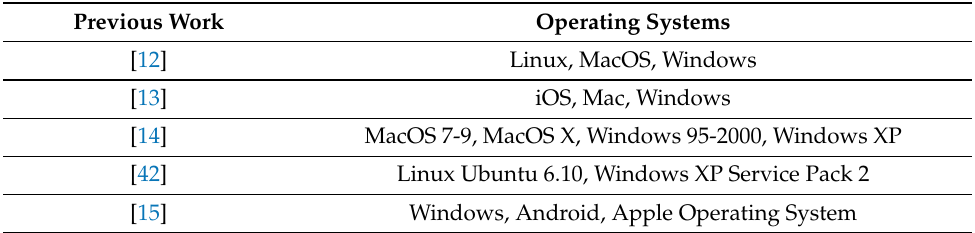
Table 11. List of operating systems analyzed in the literature.